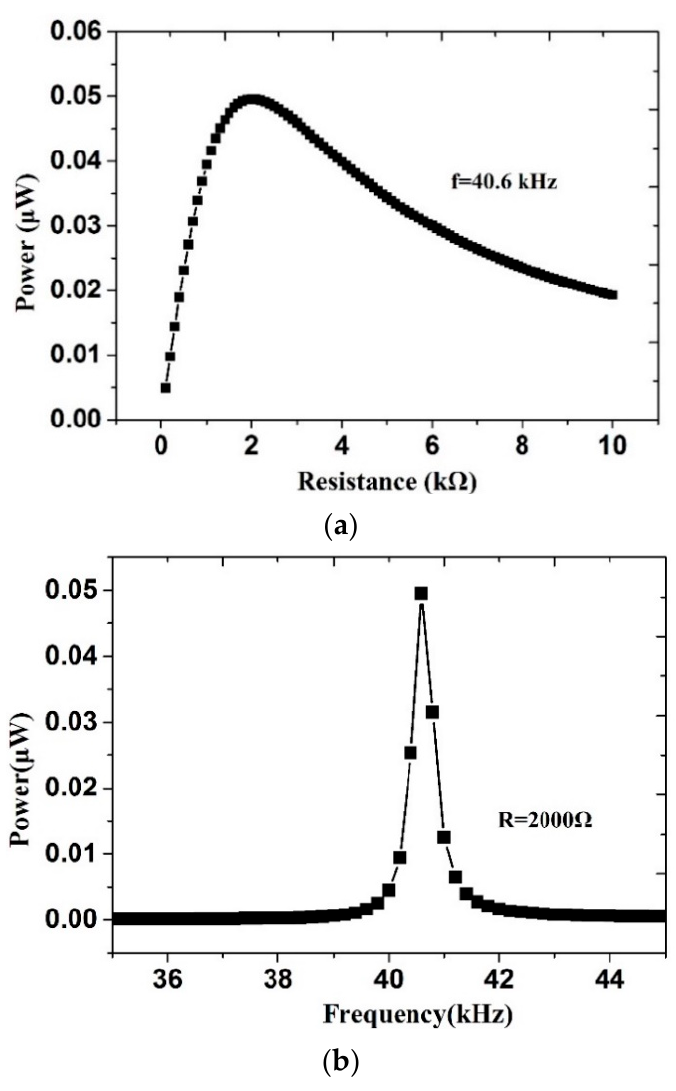
Figure 9. The relationship of output power: ( a ) with external resistance and ( b ) with frequency. Based on the above information, it was found that considerable output power could be obtained with the dual-resonator structure. As shown in Table 4, with a similar acoustic pressure level, the power density of this quarter-spherical AEH was higher than other piezoelectric energy harvesters. In addition, this structure had the advantage of collecting multi-directional energy, so it could improve the energy conversion e ffi ciency of acoustic sources in the